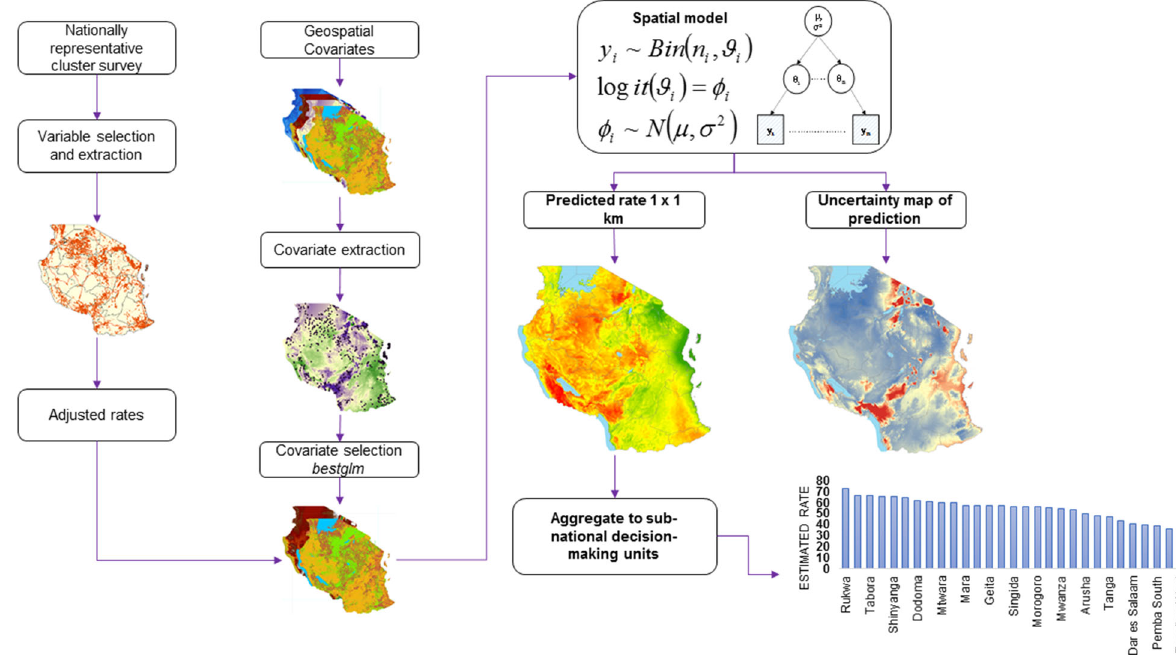
Fig. 1 Methodology for school attendance modelling. Overall schematic fl ow of the geospatial analysis of out-of-school rates.